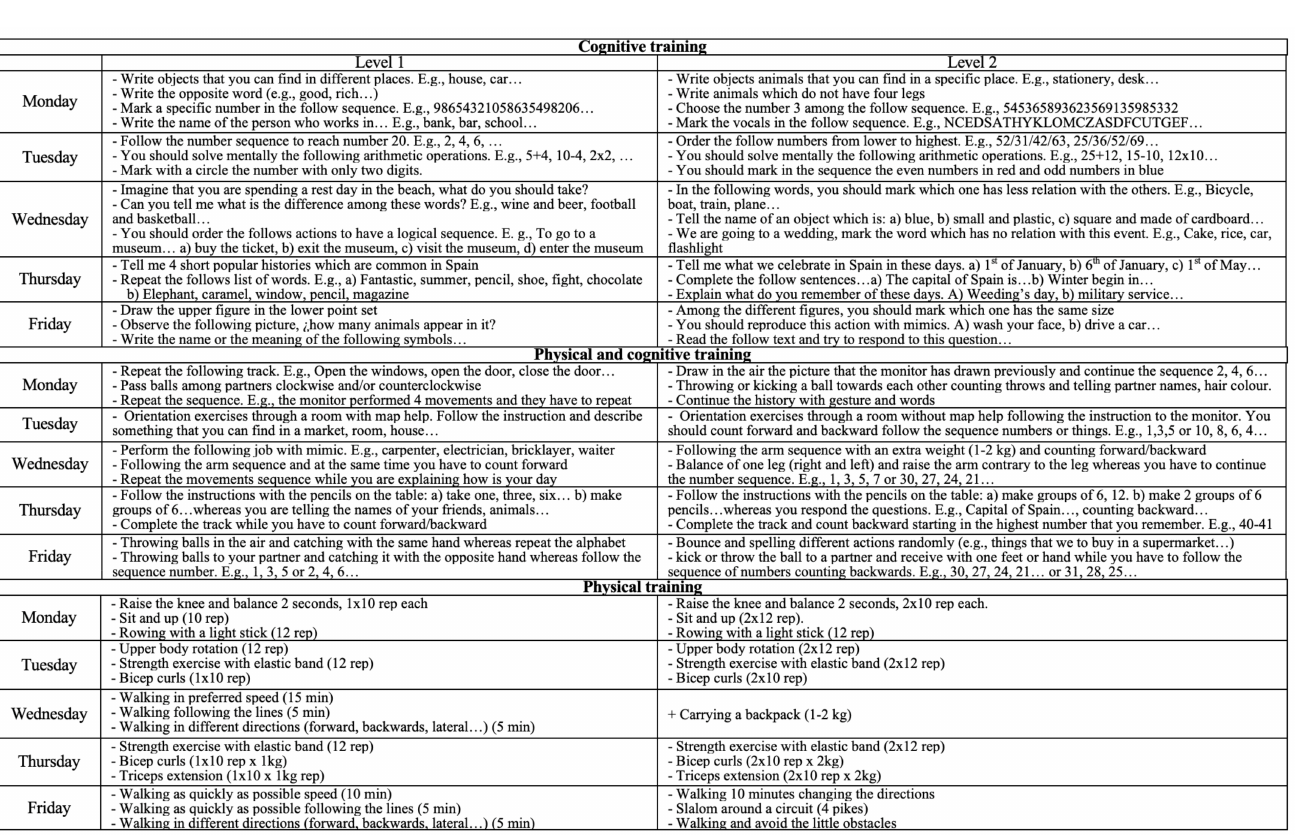
Figure 2. Example of the task performed by each experimental